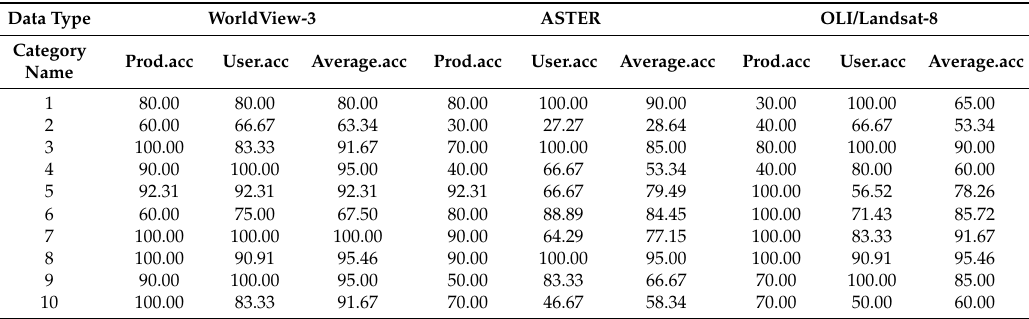
Table 4. Each class’ producer accuracy, user accuracy and average accuracy of WorldView-3, ASTER, and OLI/Landsat-8 data respectively